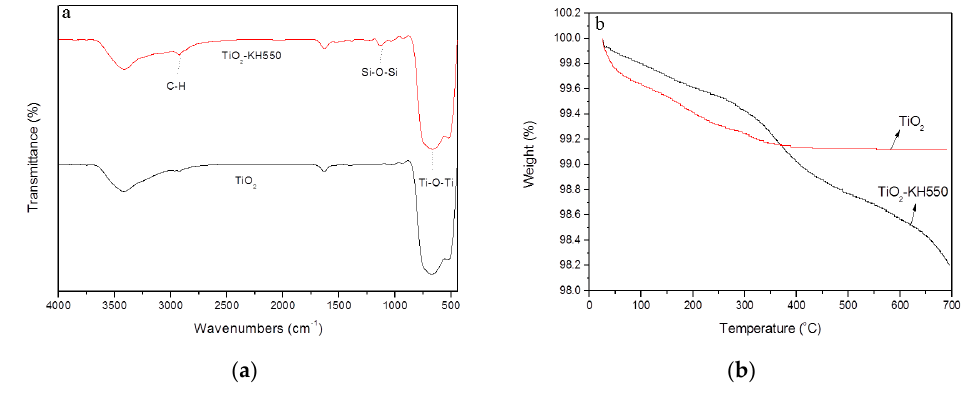
Figure 3. FTIR spectra ( a ) and TGA ( b ) of TiO 2 and TiO 2 -KH550.